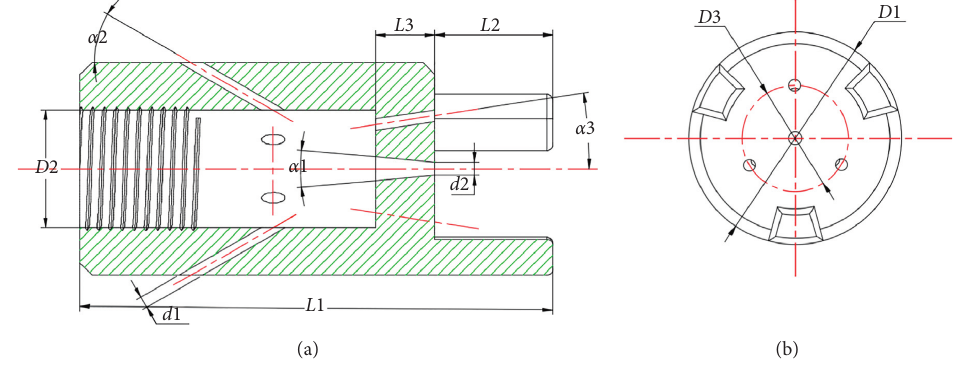
Figure 1: Structure diagram of the self-propelled multihole jet bit with the support plate.